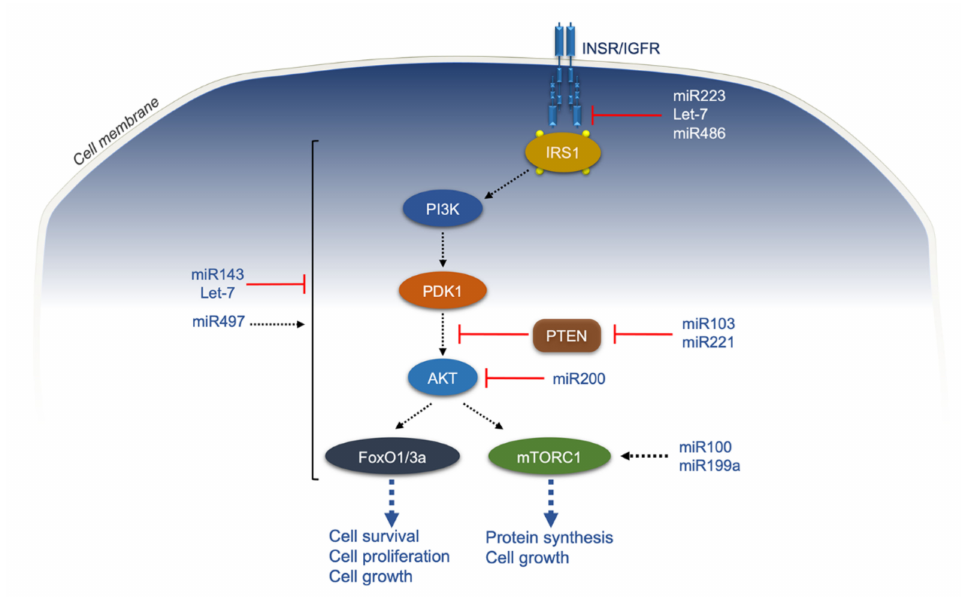
Figure 3. Actions of miRNAs in cancer and insulin resistance. INSR/IGFR, insulin receptor/insulin- like growth factor receptor; IRS1, INSR substrate 1; PI3K, phosphoinositide 3-Kinase; PDK1, phosphoinositide-dependent protein kinase-1; PTEN, phosphatase and TENsin homolog deleted on chromosome 10; AKT, Ak strain transforming/protein kinase B; FoxO1/3a, forkhead box protein O1/3a; mTORC1, mammalian target of rapamycin complex 1; black dotted arrows, activation; red lines, inhibition; blue dotted arrow, biological effects of the downstream